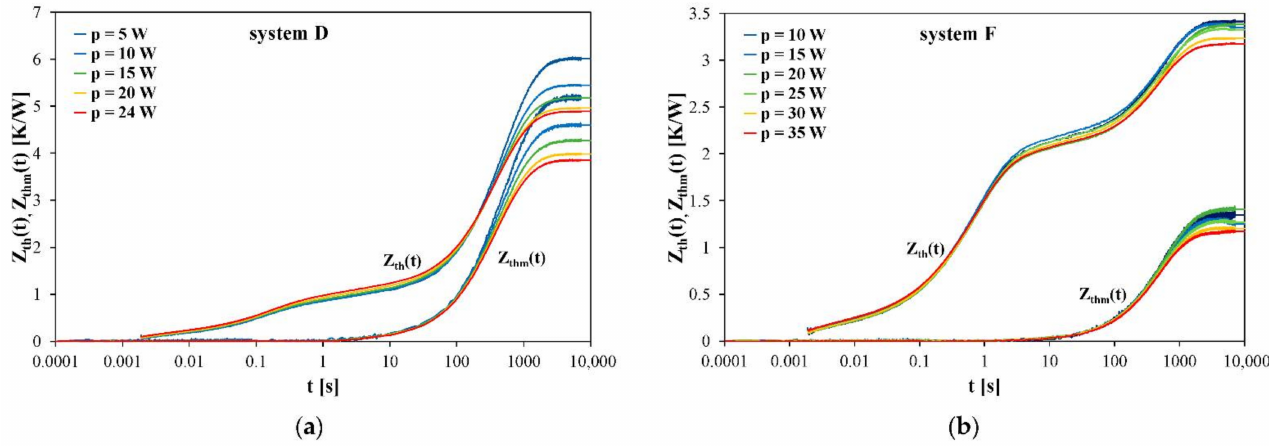
Figure 8. Transient thermal impedances Z th (t) and Z thm (t) of the investigated MOSFETs with the cooling systems ( a ) D and ( b )